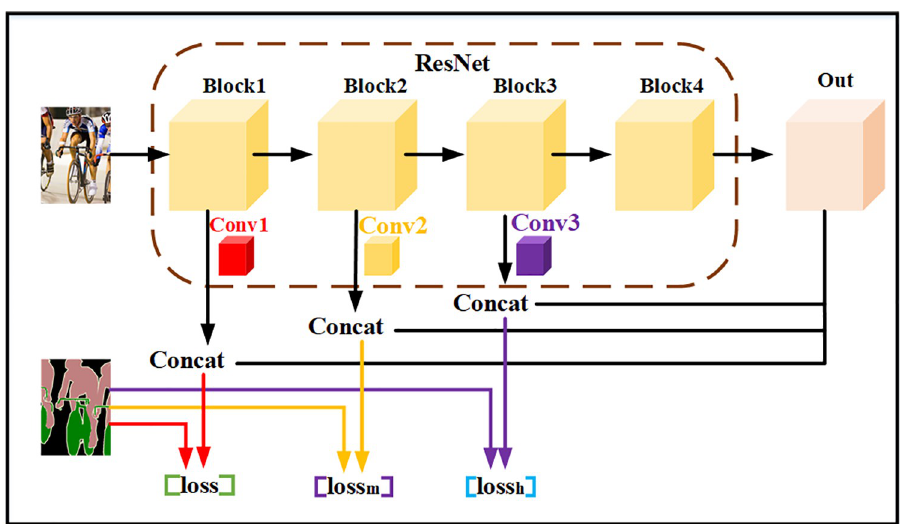
Fig 5. Optimization structure diagram of multi-loss